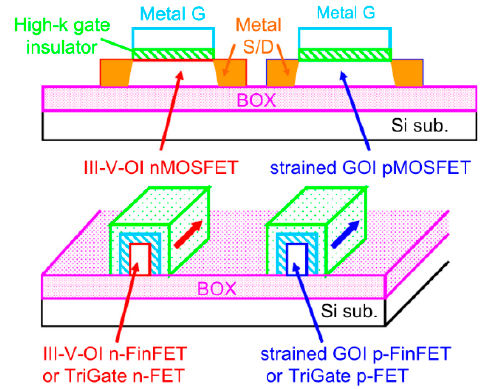
Figure 48. Structures of complementary metal oxide semiconductor (CMOS), which are composed of III-V nMOSFET and Ge p type Metal-Oxide-Semiconductor Field-Effect Transistor (pMOSFET) [342].